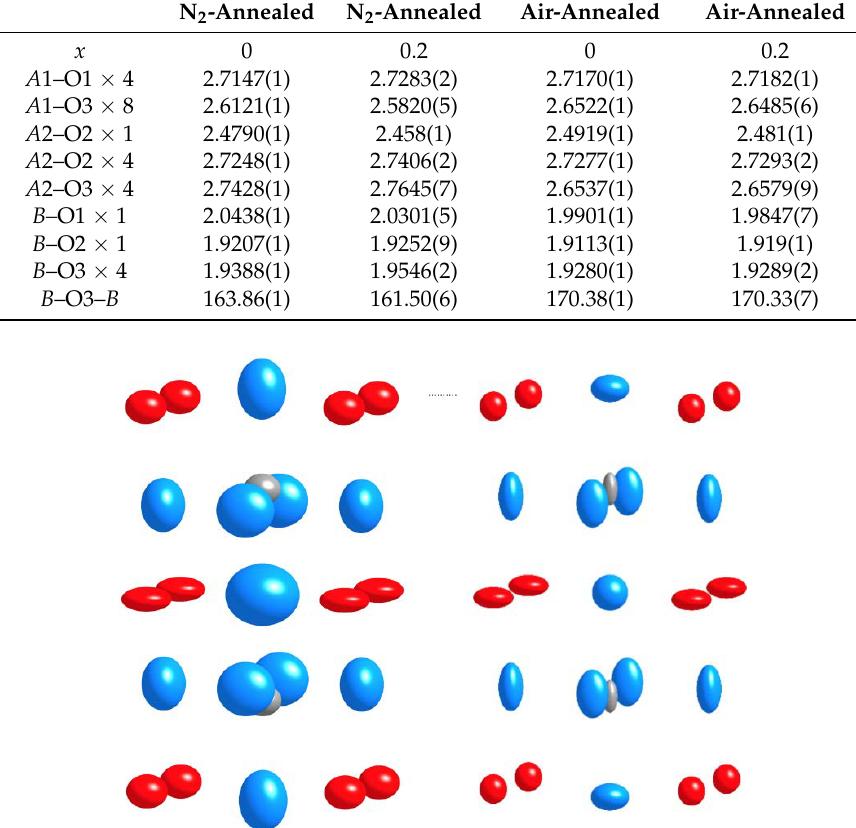
Figure 4. The perovskite block with anisotropic thermal ellipsoids of the atoms and atomic positions of x = 0.2 phase ( left , N 2 -annealed, right , air-annealed). The occupancies of the O1 and O3 positions are 27%, 85% in N 2 -annealed and 64%, 100% in air-annealed oxides. (O is blue, A is red, B is gray). The bond valence sums (BVS) calculated for the A and B cations in the x = 0.0 and 0.2 crystal